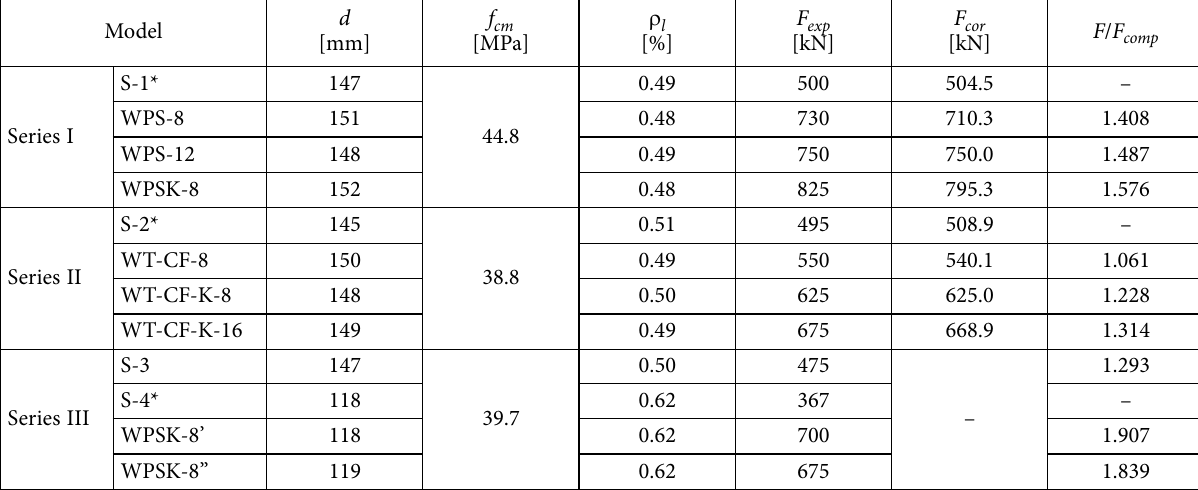
Table 5. The characteristics of the models considered in the research by Urban et al. (2010) Model